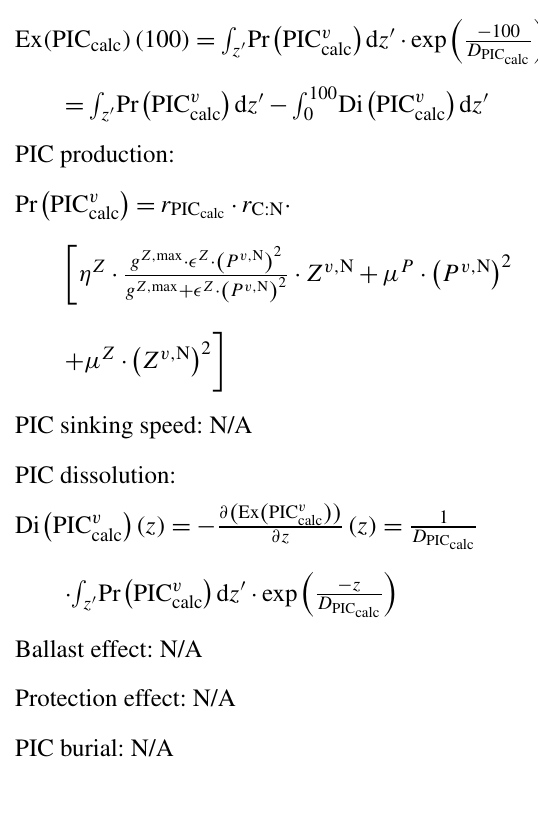
Table C13. NPZD-MRI parameters.